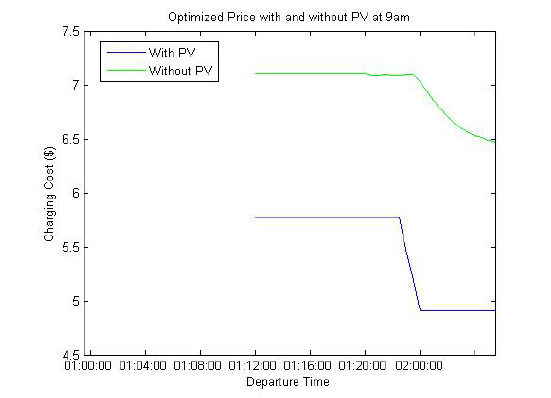
Figure 6: Resistance growth versus Charge rate and SOC [22].